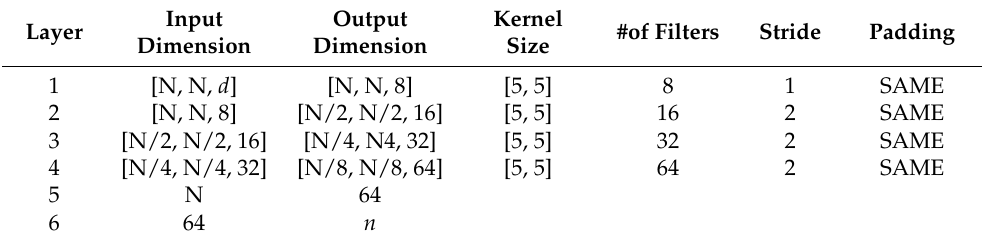
Table 2. Attributes of dense and transposed convolutional layers in the decoder f D Layer